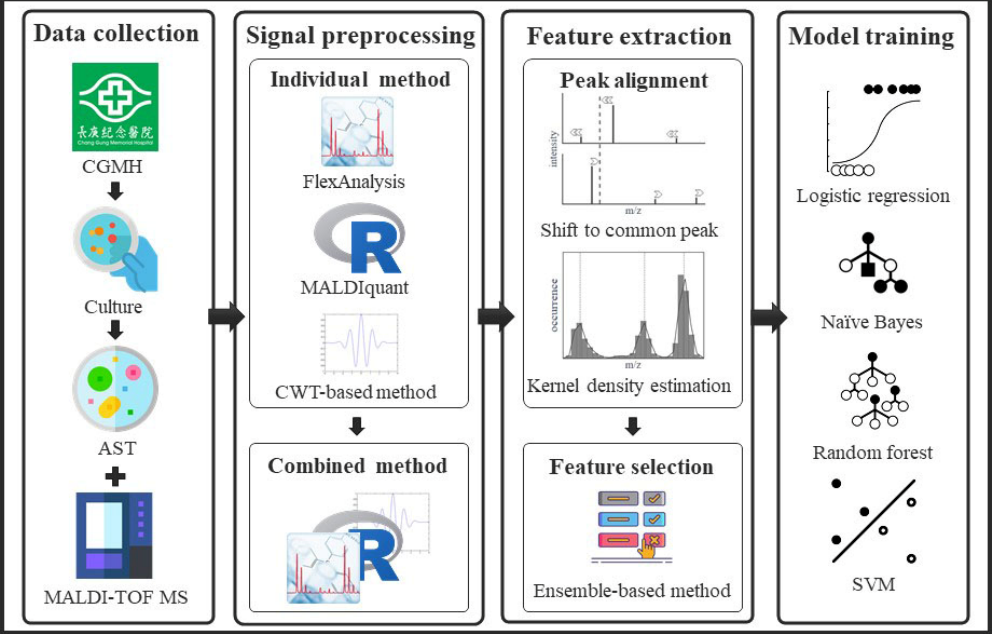
Figure 5. Flowchart of the study. Clinical strains were cultured for sample collection. Mass spectra and antibiotic resistance labels of the bacterial strains were obtained using MALDI-TOF MS and AST. In signal preprocessing, we considered the individual preprocessing methods and ensembled them to extract informative peaks from the raw mass spectra. In feature extraction, a two-stage alignment method was proposed to deal with the shifting problem of peaks and to convert them to available features. Feature selection was performed to identify important features of antibiotic re- sistance. In the model training, we constructed classification models using various machine learning algorithms. 4. Materials and Methods This study was conducted in four parts: data collection, data preprocessing, feature extraction, and model training. Clinical isolates were collected and cultured for species identification and AST. The mass spectra and antibiotic resistance labels of the bacterial isolates were obtained using MALDI-TOF MS and AST, respectively. In signal prepro- cessing, we considered individual preprocessing methods and combined them to extract informative peaks from the raw mass spectra. In feature extraction, a two-stage alignment method was proposed to deal with the shifting problem of peaks and convert them into available features. Feature selection was performed to identify the important features of antibiotic resistance. In model training, we constructed classification models using vari- ous machine learning algorithms. A flowchart of this study is presented in Figure 5. 4.1. Bacterial Isolates All isolates analyzed in this study were collected from the Chang Gung Memorial Hospital (CGMH), Linkou Branch, and Kaohsiung Branch, Taiwan. To conduct a proof- of-concept study addressing the impact of MS data preprocessing on AST prediction, four bacterial species were used: Acinetobacter baumannii , Acinetobacter nosocomialis , Enterococ- cus faecium , and Group B Streptococci (GBS). It should be noted that both gram-positive bacteria (i.e., E. faecium and GBS) and gram-negative bacteria (i.e., A. baumannii and A. nosocomialis ) were included to further investigate this generalization. Clinical isolates from the Linkou Branch were used as the training dataset, whereas those from the Kaohsiung Branch were used as the independent testing dataset. Bacterial specimens were collected from the patients and cultured for MALDI-TOF MS and AST. The antibiotics used for each bacterium in AST were ciprofloxacin (CIP) for